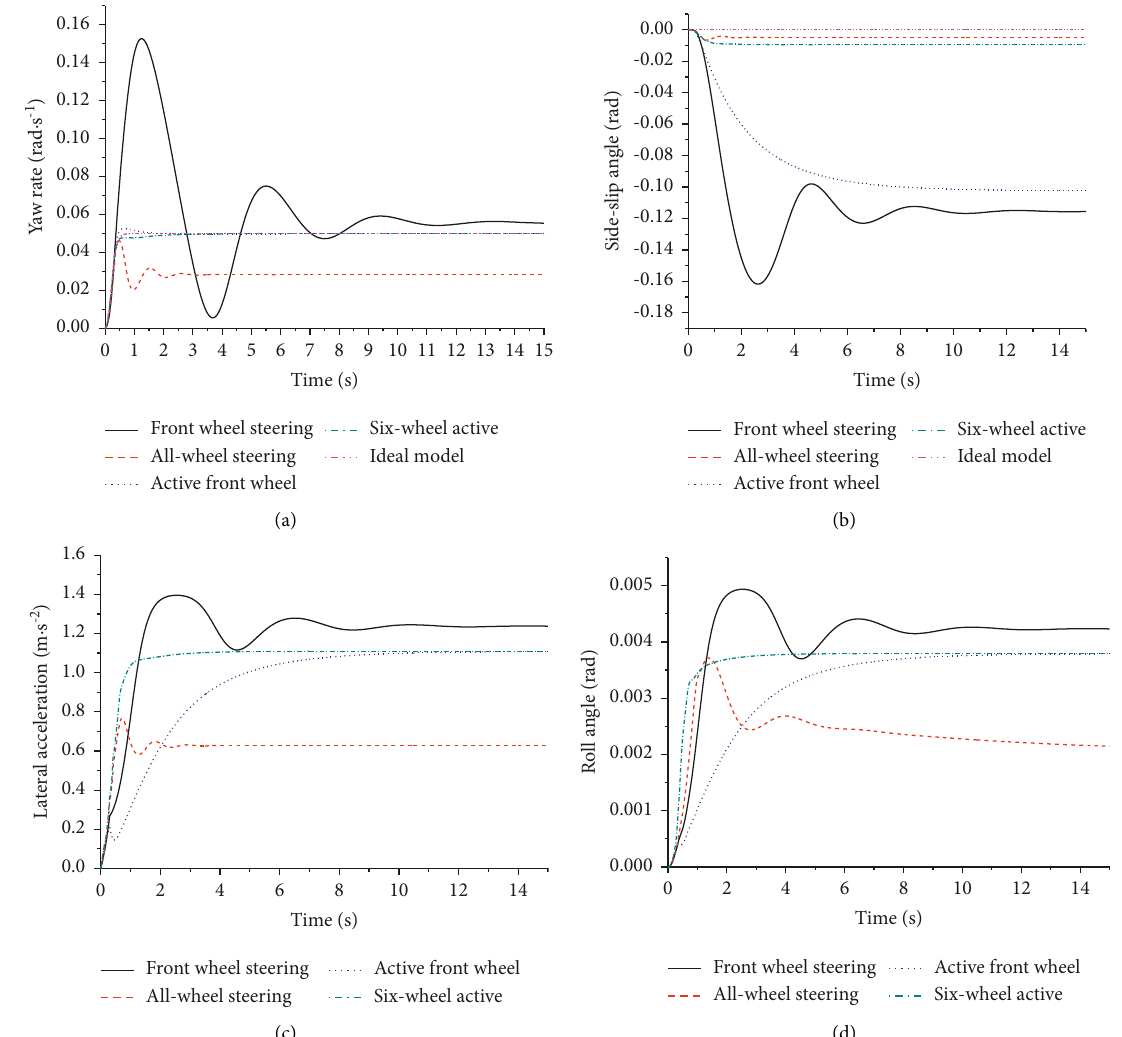
Figure 10: Comparison of different control strategies (80 km/h). (a) The yaw rate. (b) The side-slip angle. (c) Lateral acceleration. (d) The roll